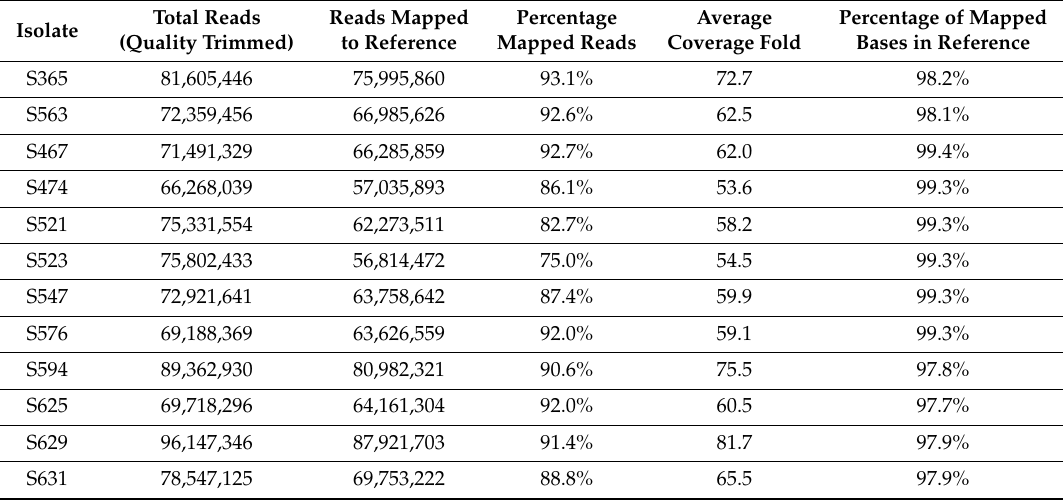
Figure1. Heatmapanddendrogrambasedonpathogenicity(virulence / avirulence)of12 Pucciniatriticina (Pt) isolates, and a phylogenetic tree based on the identified single nucleotide polymorphism (SNPs) across the 12 Pt isolates. ( A ) The dendrogram separates the 12 isolates into three distinct clades. ( B ) The phylogenetic tree also separates the 12 isolates into three clades, consistent with those of the dendrogram. The numbers shown on the tree branches are the percentage of bootstrap replicates (1000) supporting the cluster. Table 1. Mapping information for the 12 Puccinia triticina (Pt)